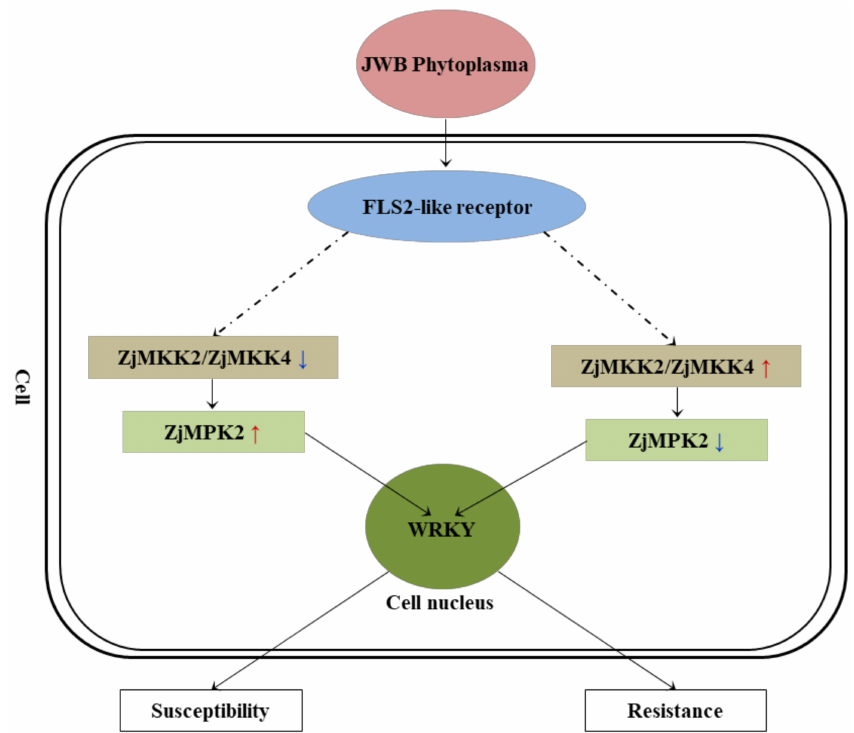
Figure 6. Possible MAPK cascades pathway of Chinese jujube under JWB phytoplasma infection. Di ff erent color arrows indicate up-regulation (Red) and down-regulation